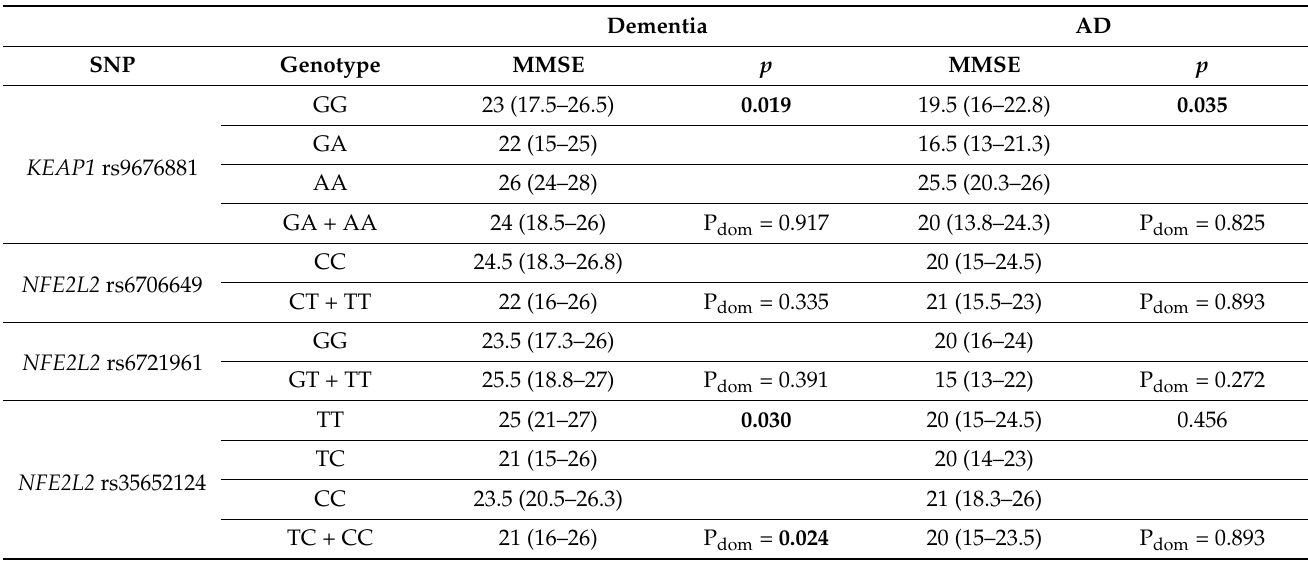
Figure 1. Comparison of A β 42 cerebrospinal fluid levels between different IL1B rs16944 genotypes in: ( a ) whole patient cohort; ( b ) Alzheimer’s disease patients only.